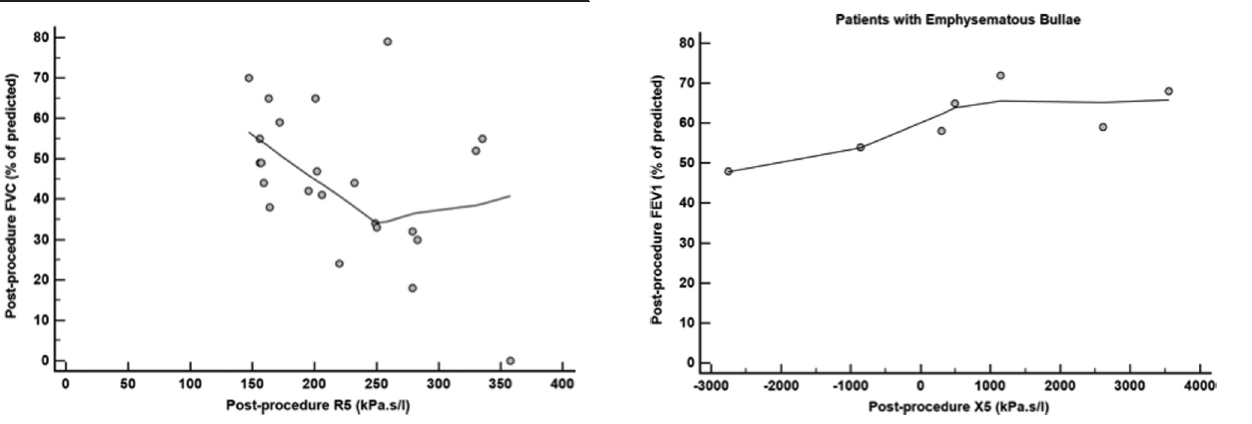
Scatter plot showing correlation between FEV1 and X5 post proce- dure in emphysematous